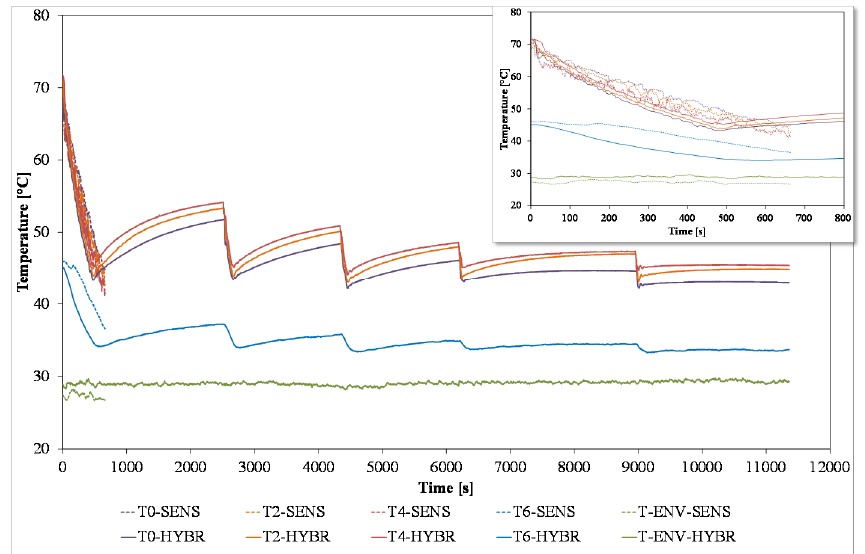
Figure 7. Comparison between discharging phases for both TES configurations at 12 kg/min, starting from 70 °C. Dynamic evolution of three reference internal temperatures along the height of the tank, the temperature of the insulation and the ambient temperature. On the top-right corner is a detail of the time frame during which the sensible storage is fully discharged.